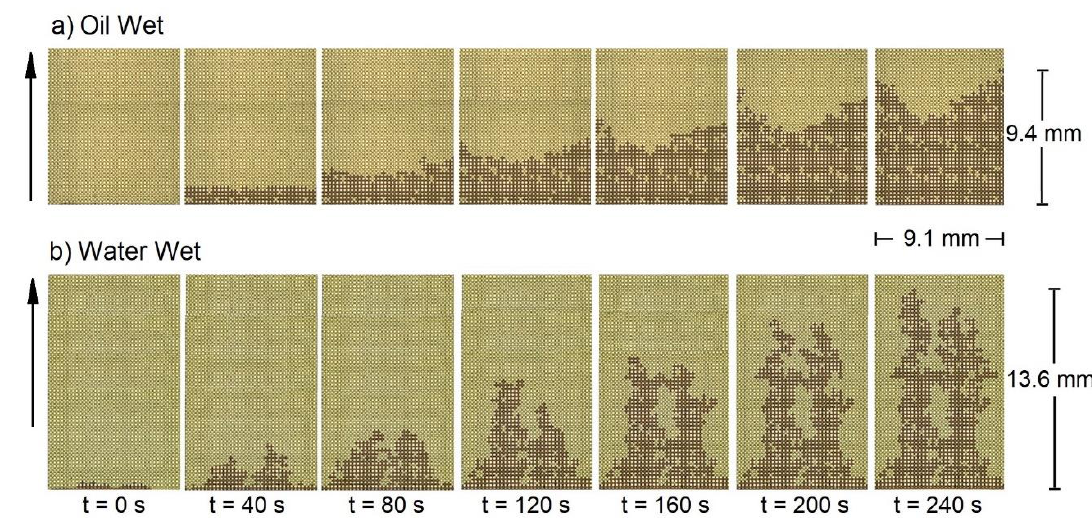
Figure 10. Sequence of images illustrating the water invasion until t = 240 s: ( a ) oil-wet model pore network; ( b ) water-wet model pore network.